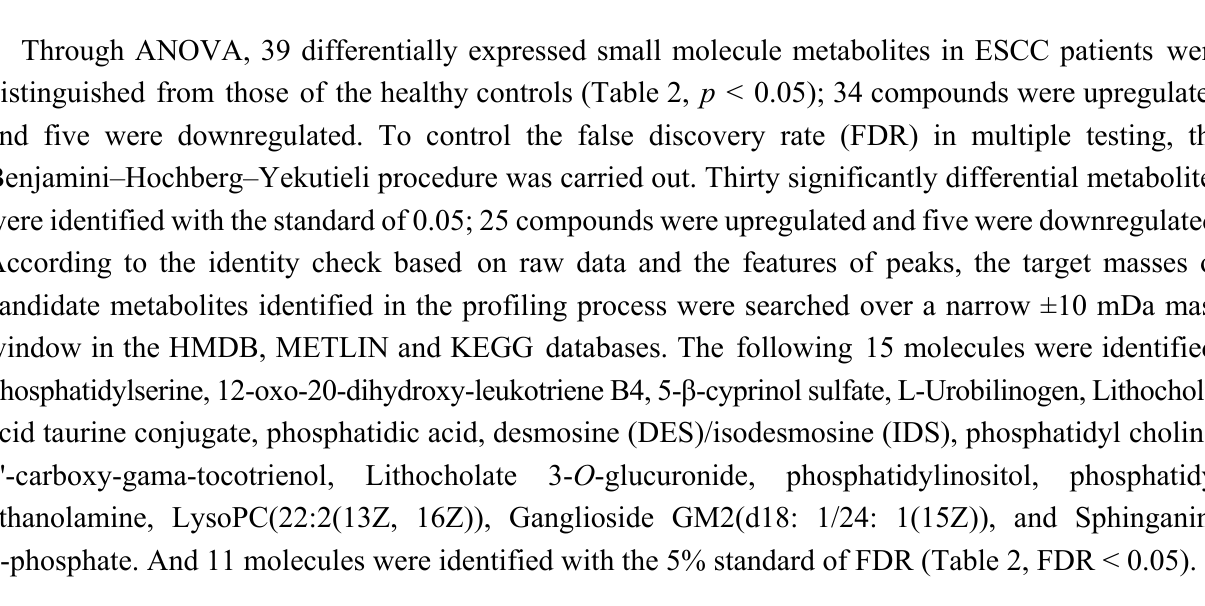
Table 2. Plasma differential metabolites associated with ESCC